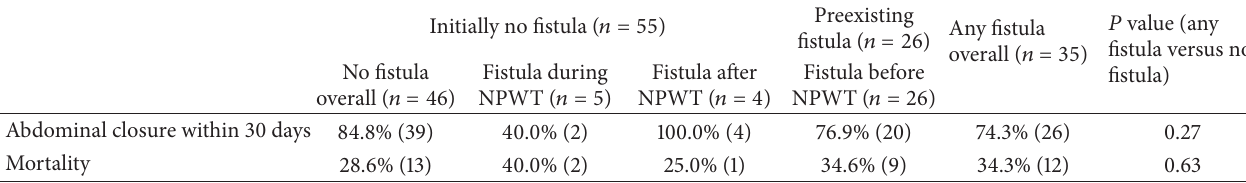
Table 4: Outcome.